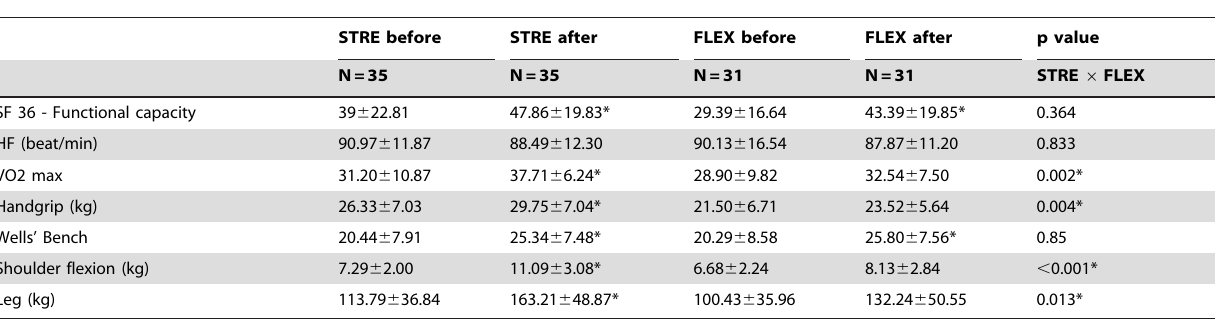
Table 2. Physical fitness assessment at baseline and after 16 weeks.